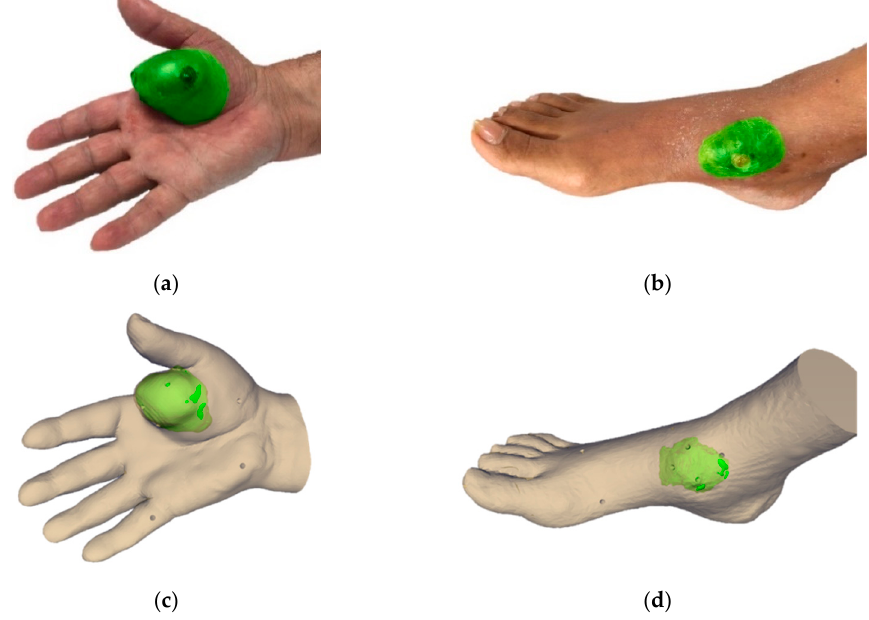
Figure 1. Representation of the clinical cases. Case 1: patient with a soft-tissue sarcoma (green) located on the right hand. ( a ) Real image and ( c ) virtual image. Case 2: patient with a soft-tissue sarcoma (green) in the right foot. ( b ) Real image and ( d ) virtual image.